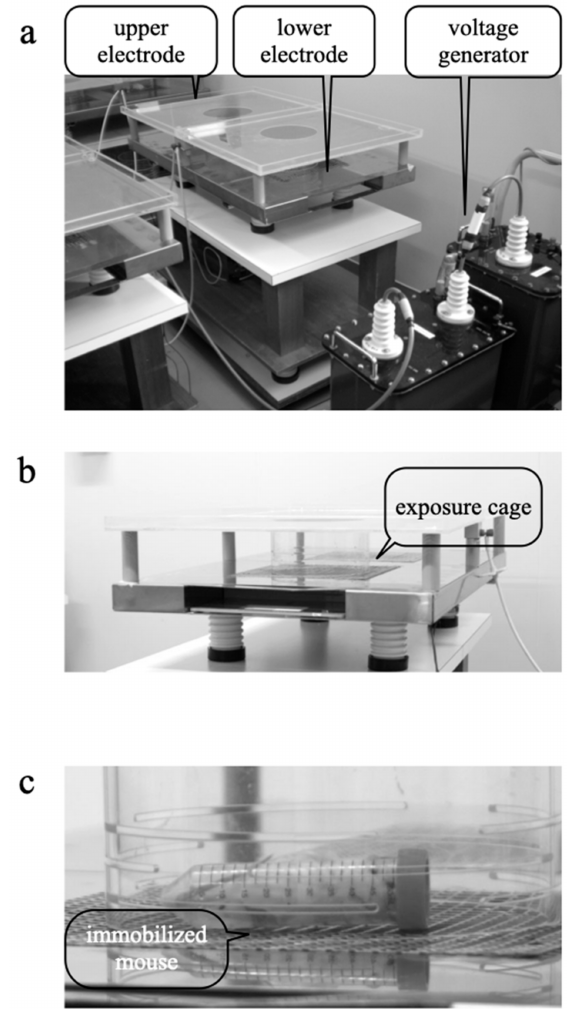
Figure 1. Electric field exposure system. ( a ) Voltage generator and parallel plate electrodes are shown. ( b ) Exposure cage had 100 mm × 5 mm slits spaced at 5 mm intervals. ( c ) A 50 mL centrifuge tube was used to immobilize the